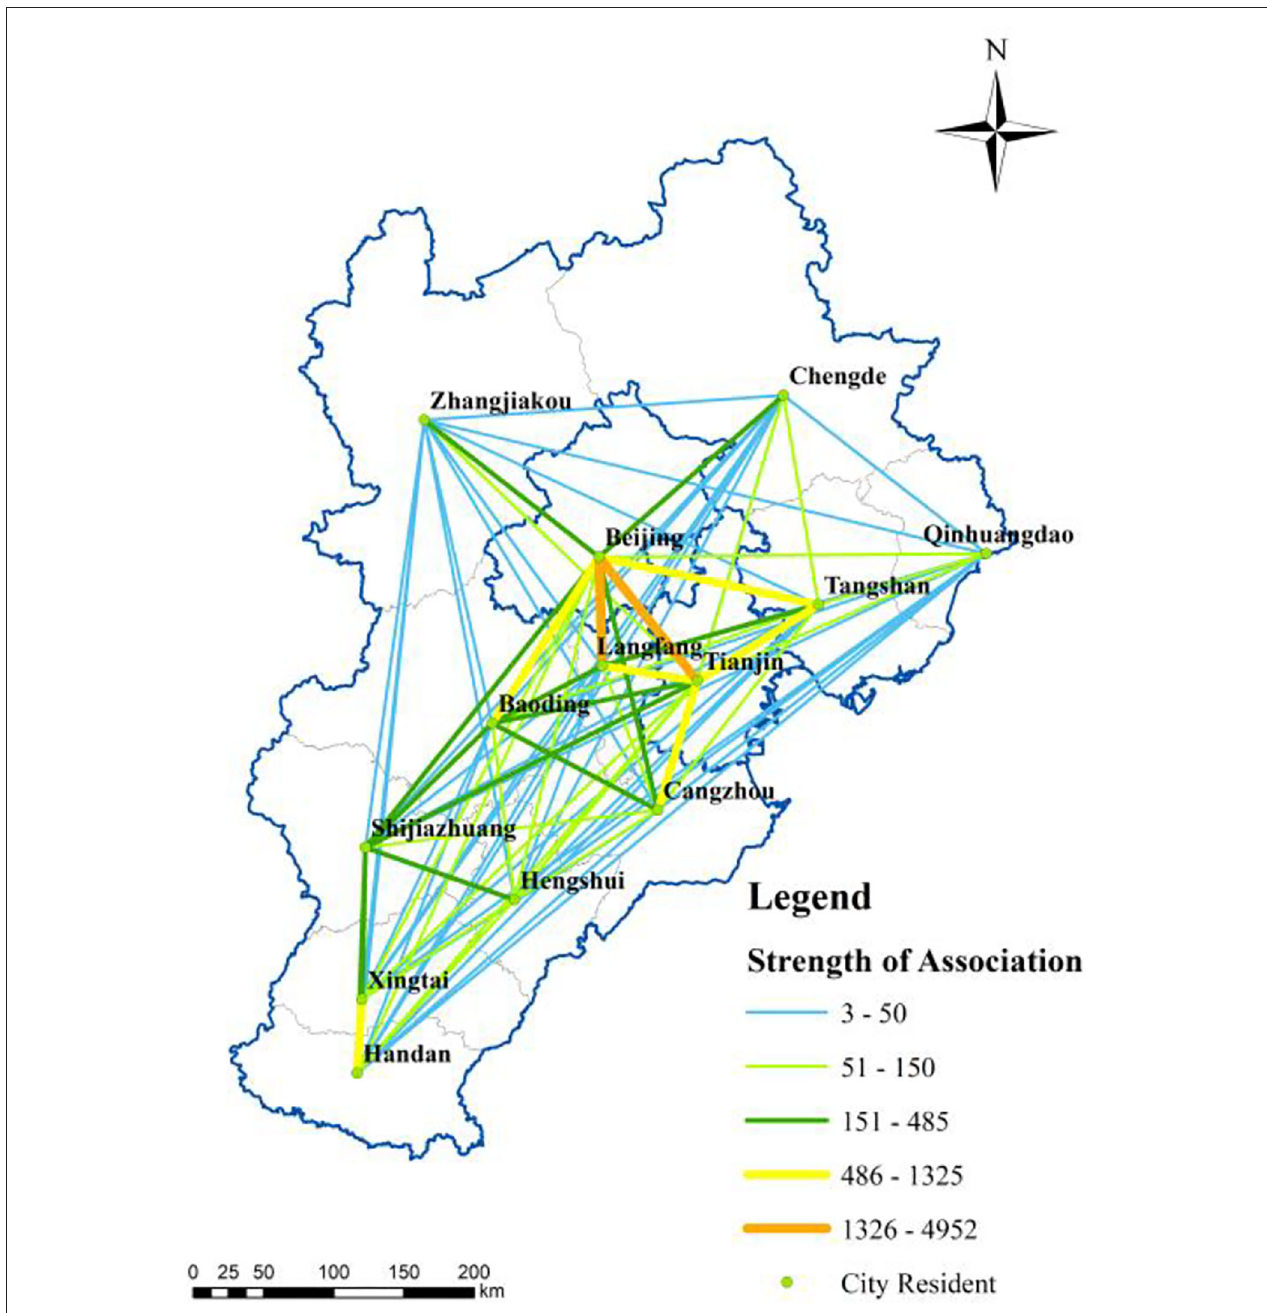
FIGURE 5 | Association intensity among